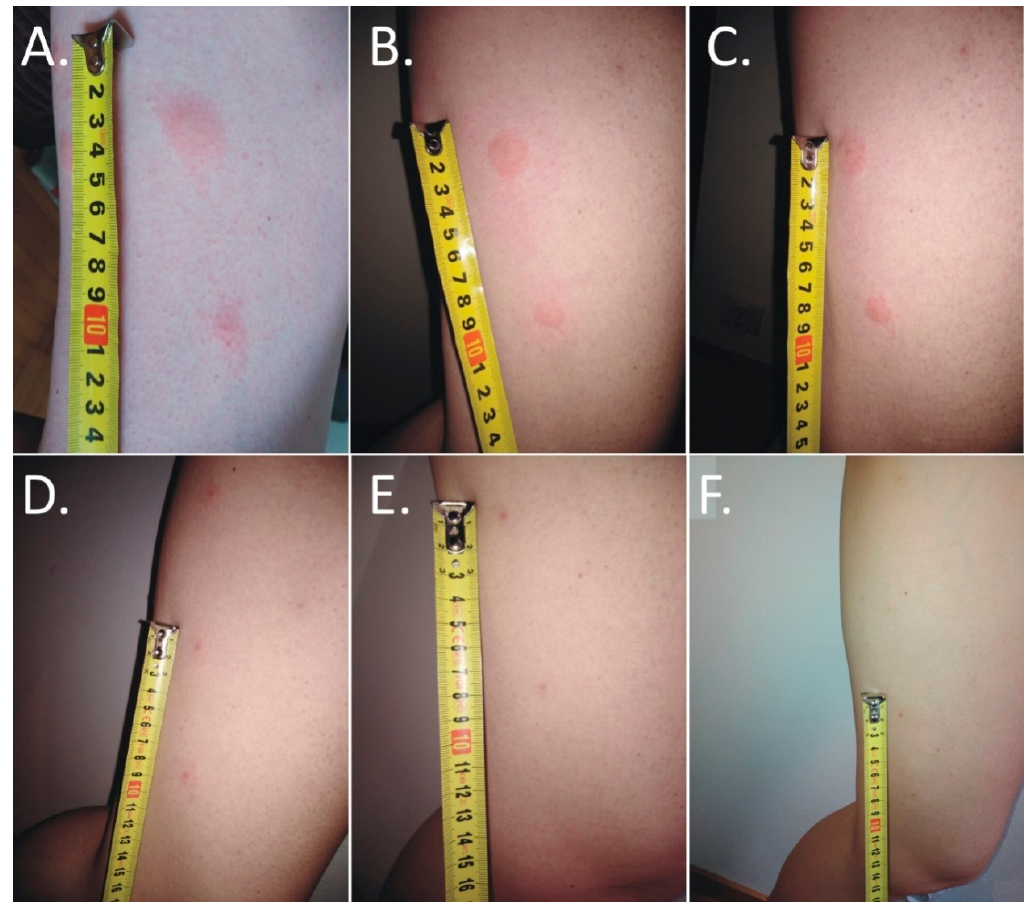
Figure 1. Evolution of skin lesions after deer ked ( Lipoptena cervi ) bites. ( A , B ) Multiple painful urticarial pink papules on an erythematous base on the thigh: ( A ) irregular one day after the bite; ( B ) more regular two days after the bite); ( C ) excoriated erythematous papules with self-limited dermatitis (three days after the bite); ( D ) hyperpigmented papules on an erythematous base (5 days after the bite); ( E ) hyperpigmented papules on an erythematous base (4 weeks after the bite); ( F ) residual hyperpigmented papules 6 weeks after the bite).